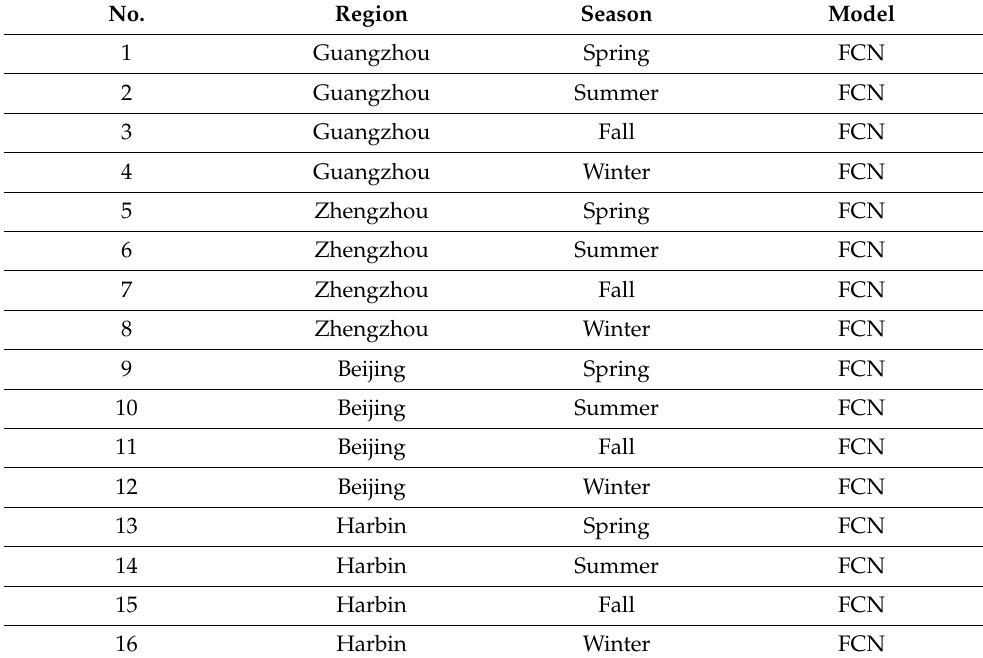
Table 3. Experimental setup for